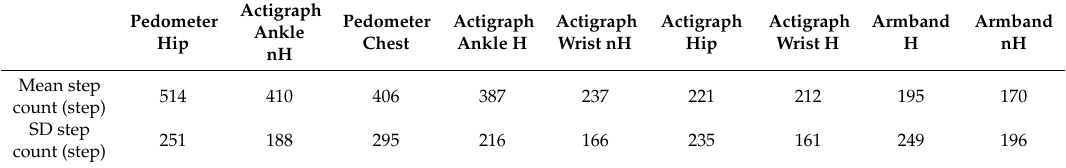
Figure 2. Distance measured by the practitioner and estimated from step counts reported by all devices according to type and placement. nH: non hemiparetic side; H: hemiparetic side. * p < 0.05 at the end of the Wilcoxon test comparing the distance measured by the examiner and that estimated by the device from the number of steps. Table 2. Step count reported by the devices. nH: non hemiparetic side; H: hemiparetic side.